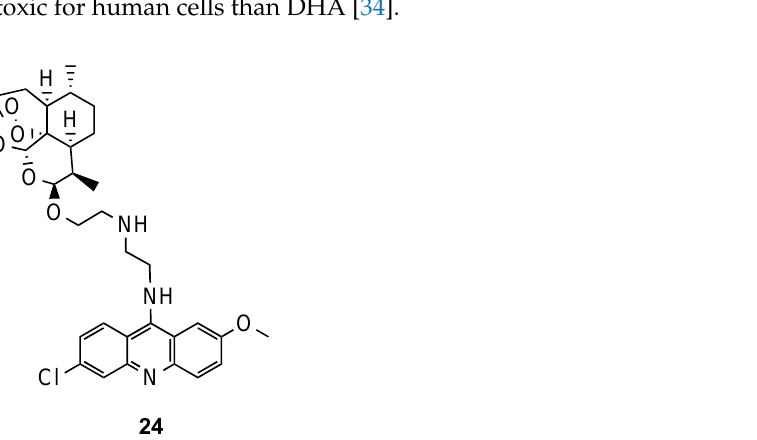
Figure 16. Most active compound 24 developed by Joubert and co-workers [34].